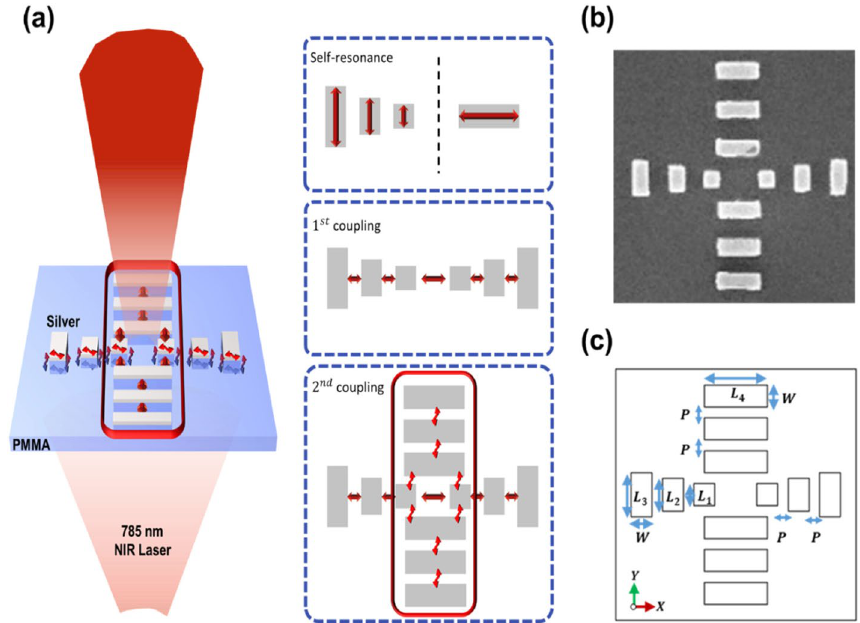
Fig. 1 a Schematic of a metal-based plasmonic nanostructure (MPN) for amplifying a specific optical signal. The MPN has three resonance parts to enhance the optical signal. b SEM image of the MPN, on which silver was deposited to obtain plasmonic effects. c Dimensions of the MPN for enhancing the electric